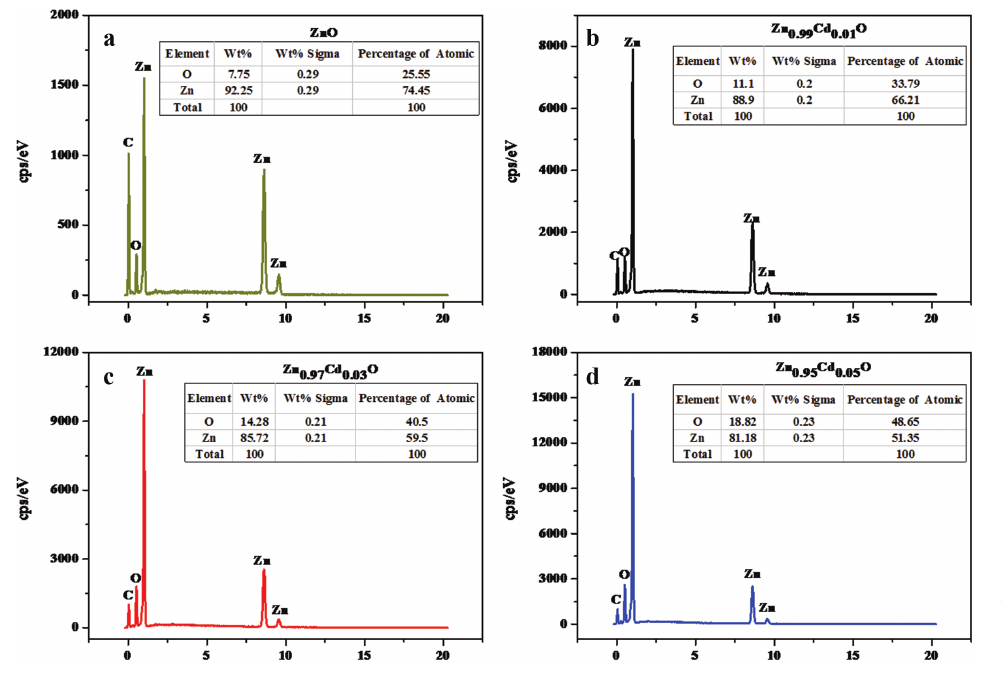
Figure 5: EDS pattern